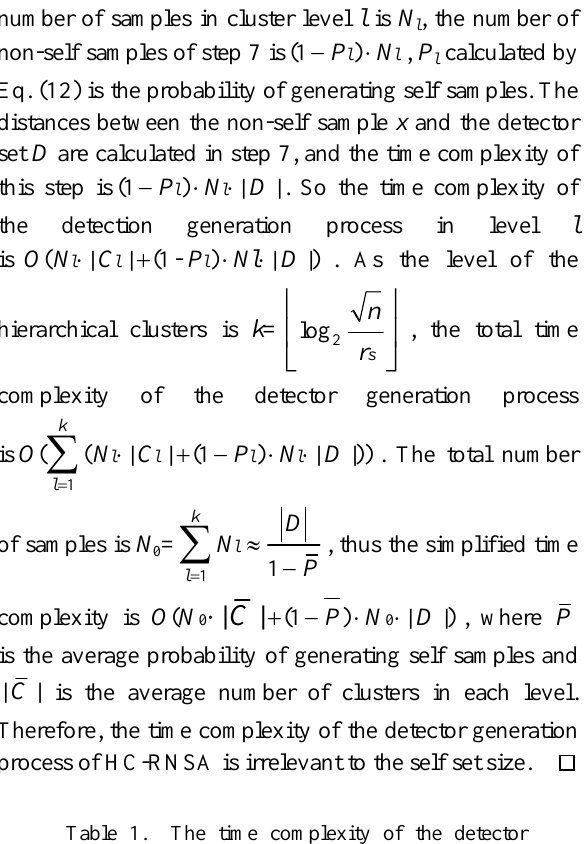
Table 1. The time complexity of the detector